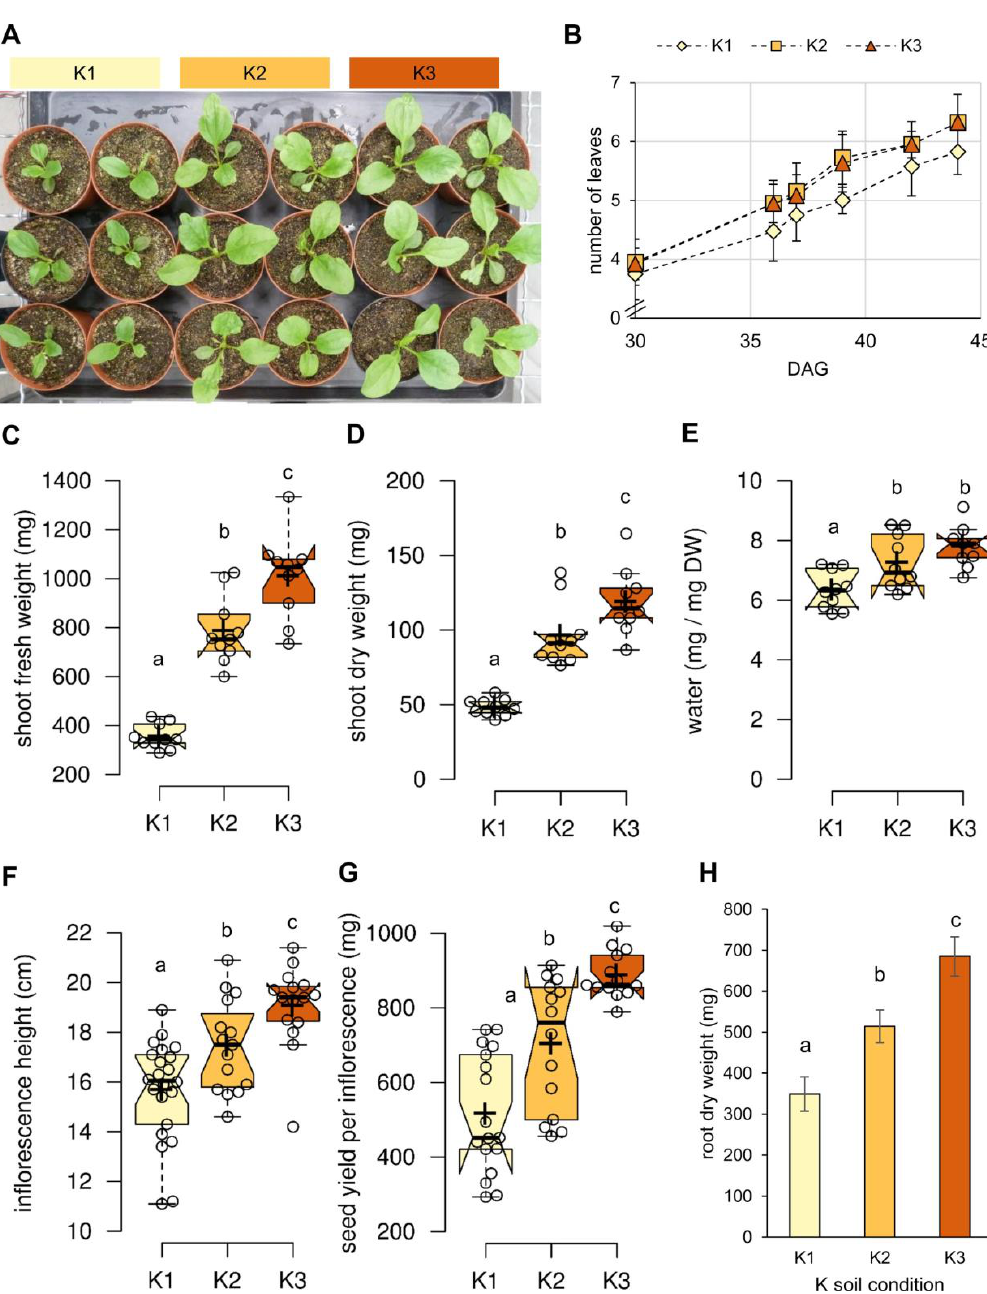
Figure 1. Effect of different soil K levels on biomass of P. major . ( A ) Exemplary pictures of 5-week old P. major plants grown under 3 different doses of soil K. ( B ) Development of leaf number over a time of 15 days (data represent means from n = 15 plants per data point ± SD). ( C ) Shoot fresh weight; ( D ) shoot dry weight; ( E ) shoot water content; ( F ) inflorescence height; ( G ) number of seeds per inflorescence, and ( H ) root dry weights of K1 to K3-grown plants (bars represent means from n = 6 roots per K condition ± SE). ( C – G ) Boxplots based on values from at least n = 12 plants per soil K level. Center lines within boxes represent median, crosses are the mean values. The notches are defined as +/ − 1.58 × IQR/sqrt ( n ) and represent the 95% confidence interval for each median. Different letters denote significant changes between K treatments, according to one-way ANOVA with post-hoc Tukey HSD test ( p = 0.05).